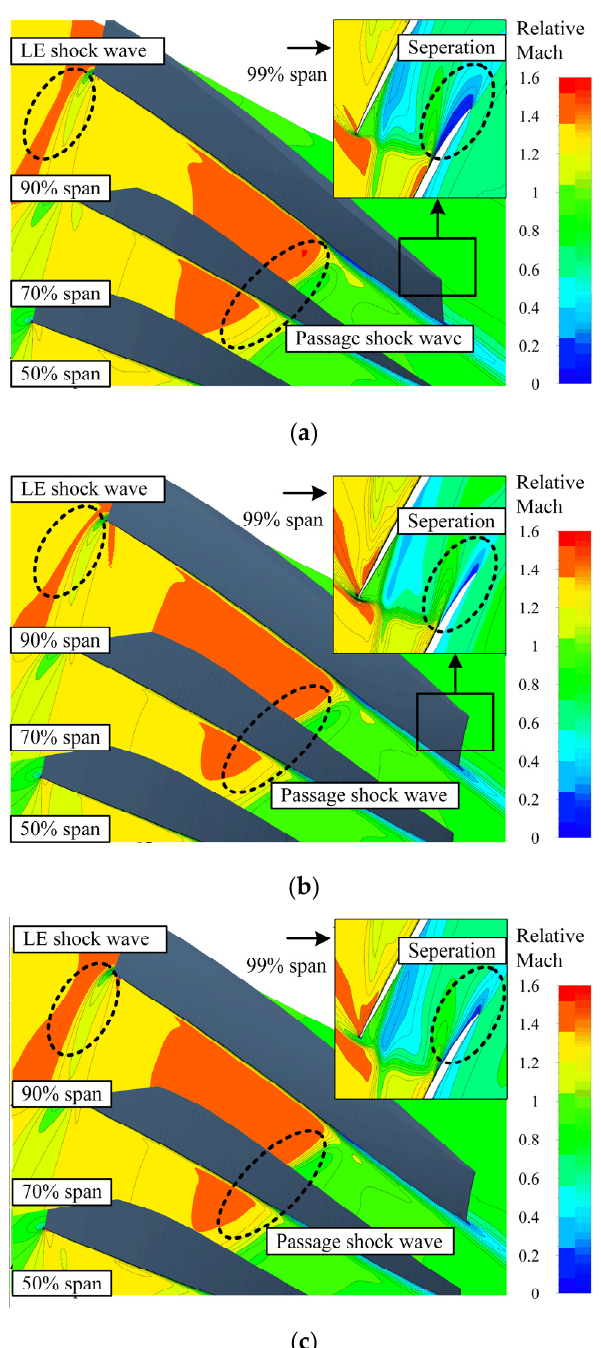
Figure 19. Relative Mach number distribution of the different rotors. ( a ) Distribution of the reference rotor. ( b ) Distribution of the GA case. ( c ) Distribution after modification by the agent.